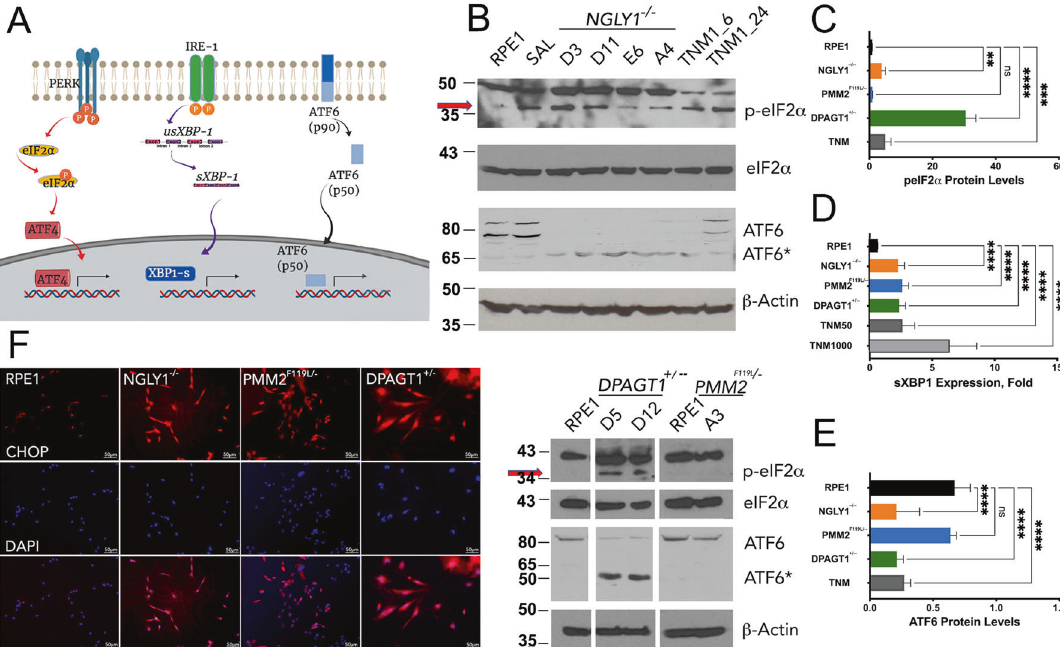
Fig. 2 Cellular models of CDG and CDDG exhibit elevated ER stress responses. A Schematic of the three major ER stress pathways (analyzed markers are framed). B Representative immunoblot images for ER stress markers in RPE-1 and different clones of isogenic CDDG (top) and CDG (bottom) lines. RPE-1 cells treated with TNM (1µM for either 6h or 24h) and salubrinal (SAL, 50µM for 24h) were used as negative and positive controls, respectively. C Quanti fi cation of p-eIF2 α levels relative to total eIF2 α protein ( n ≥ 3 per each genotype or treatment). D Expression of spliced XBP1 transcript ( n ≥ 10 per each genotype or treatment). E Quanti fi cation of ATF6(90) levels in parental and edited RPE-1 cells. ( n ≥ 3 per each genotype or treatment). Expression data in C – E are relative to levels in parental RPE-1 cells. * P <0.05, ** P <0.01, *** P <0.001, **** P <0.0001, one-way ANOVA followed by Dunnett multiple comparisons post-test. F Nuclear localization of CHOP/ATF4 in parental and edited RPE-1 cells (scale bars are 50µm).